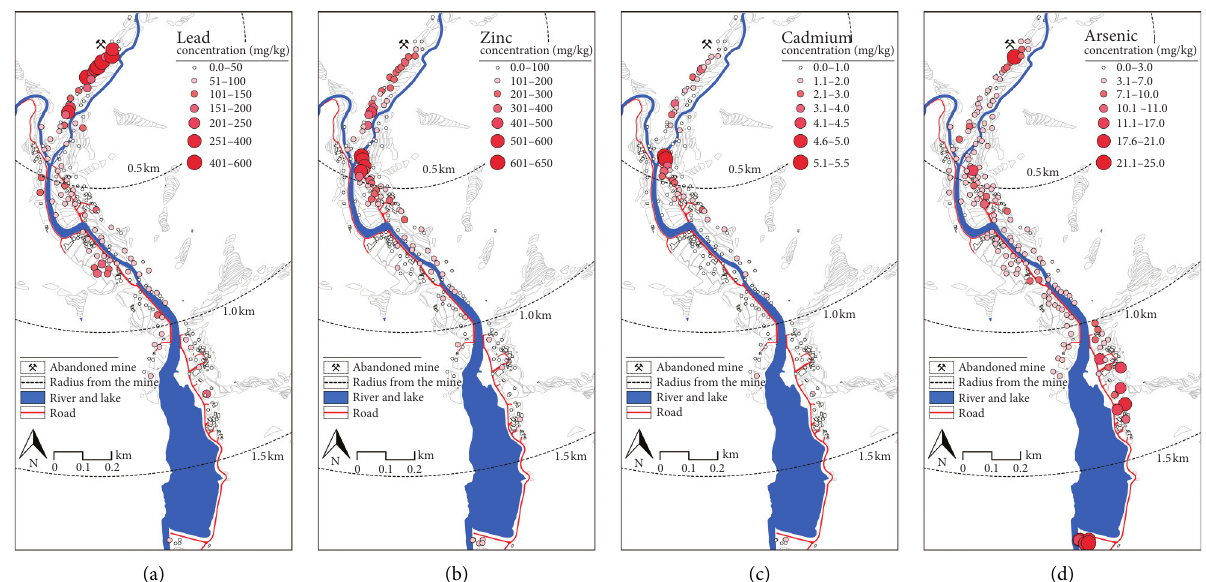
Figure 5: Distribution maps of (a) Pb, (b) Zn, (c) Cd, and (d) As in the agricultural soils of the study area. The circle size indicates the relative degree of metal(loid)